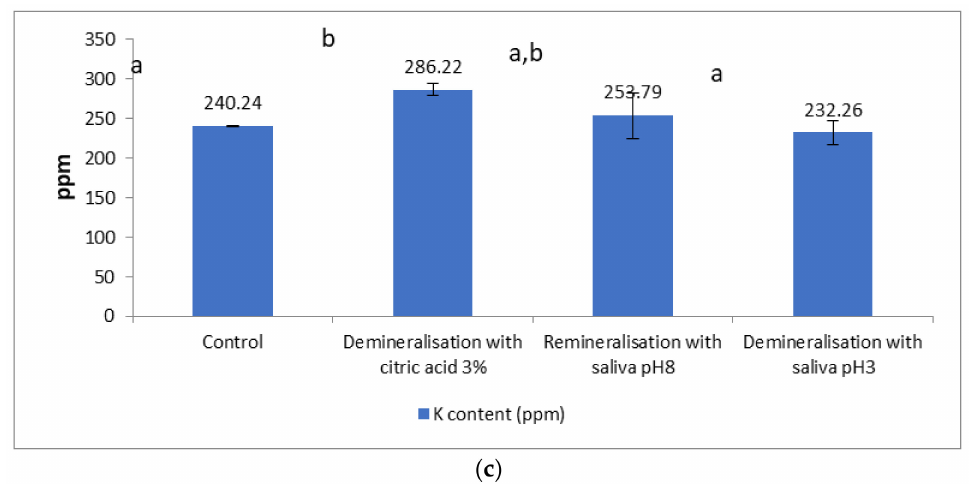
Figure 11. ( a ) Ca content (ppm) after demineralisation/remineralisation procedure; ( b ) Mg content (ppm) after demineralisation/remineralisation procedure; ( c ) K content (ppm) after demineralisa- tion/remineralisation procedure. Different letters indicate statistically significant differences p ≤